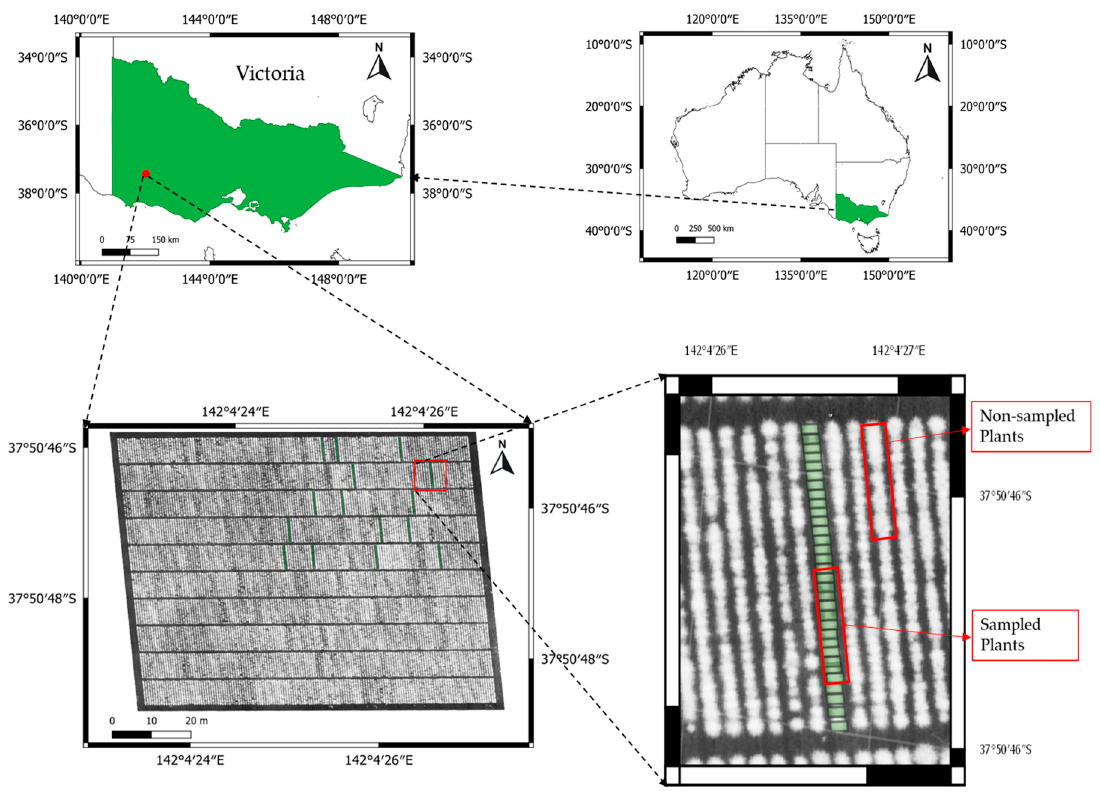
Figure 1. Study site: the perennial ryegrass experiment was conducted at the Hamilton Centre Research Station in Victoria State of Australia in 2017 and 2018. NDVI tiff file is used to display the field trial site sampled plants and non ‐ sampled plants throughout the experiment time. Table 1. Overview of the data collected from individual plants, data collection date, sensors applied and equipment used for